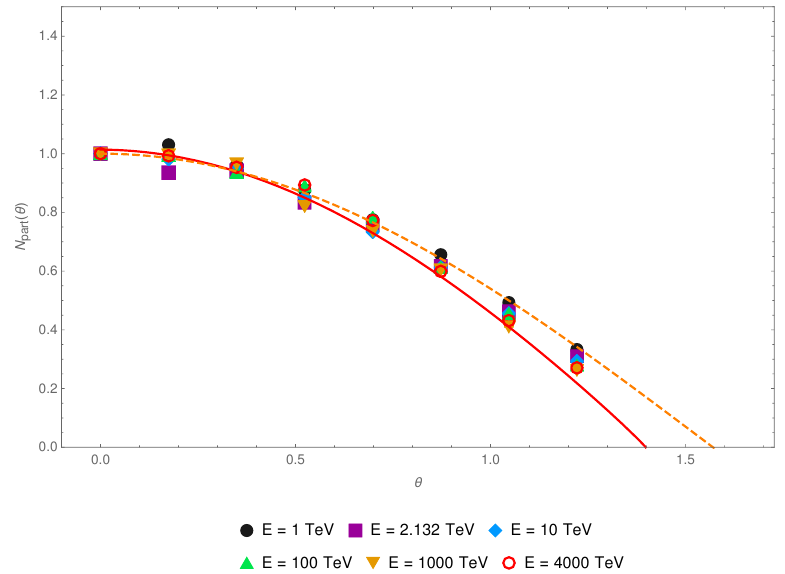
Figure 4. Normalised relation N part ( θ ) / N part ( 0 ) with fitted scaling factor F θ ( θ ) (red solid line) for muons in cascades initiated by protons. It shows how the number of secondary particles which reach the ground changes with an increasing angle of incidence of primary cosmic-ray particles. The dashed line represents the cos ( θ ) function. For clarity of the picture, only selected energies are shown.